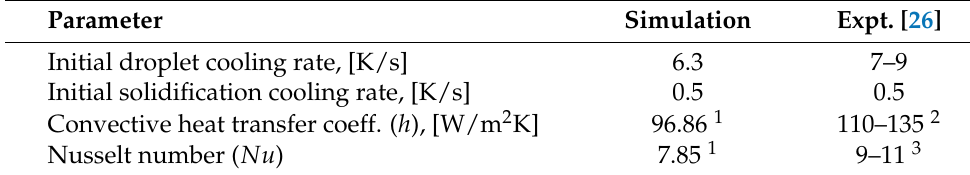
Table 3. Validation results for a single cocoa butter